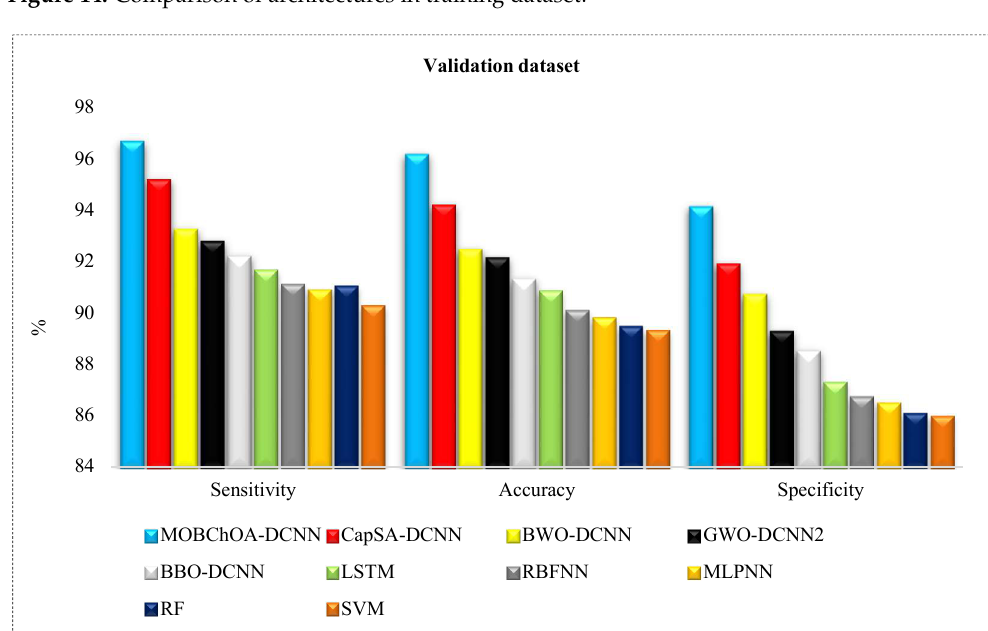
Figure 15. Comparison of architectures in validation dataset.